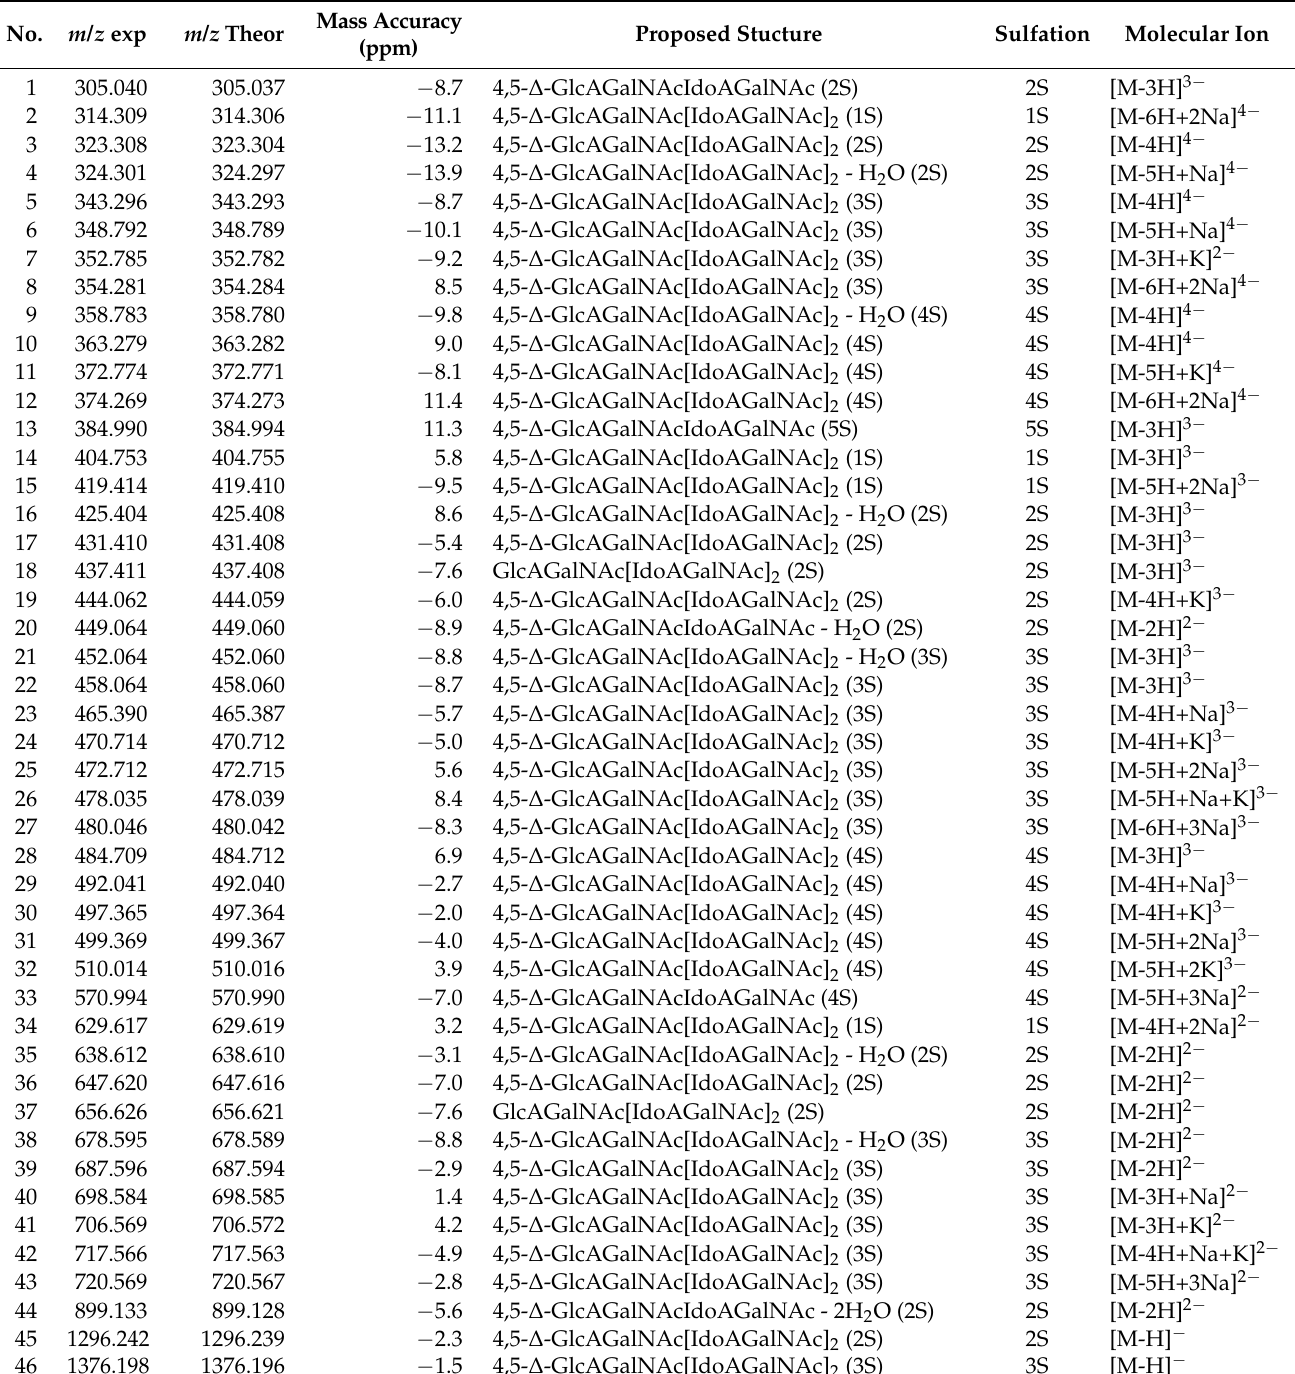
Table 1. Assignment of the major ions of CS/DS hexasaccharide fraction detected by IMS MS. n S-number of SO 3